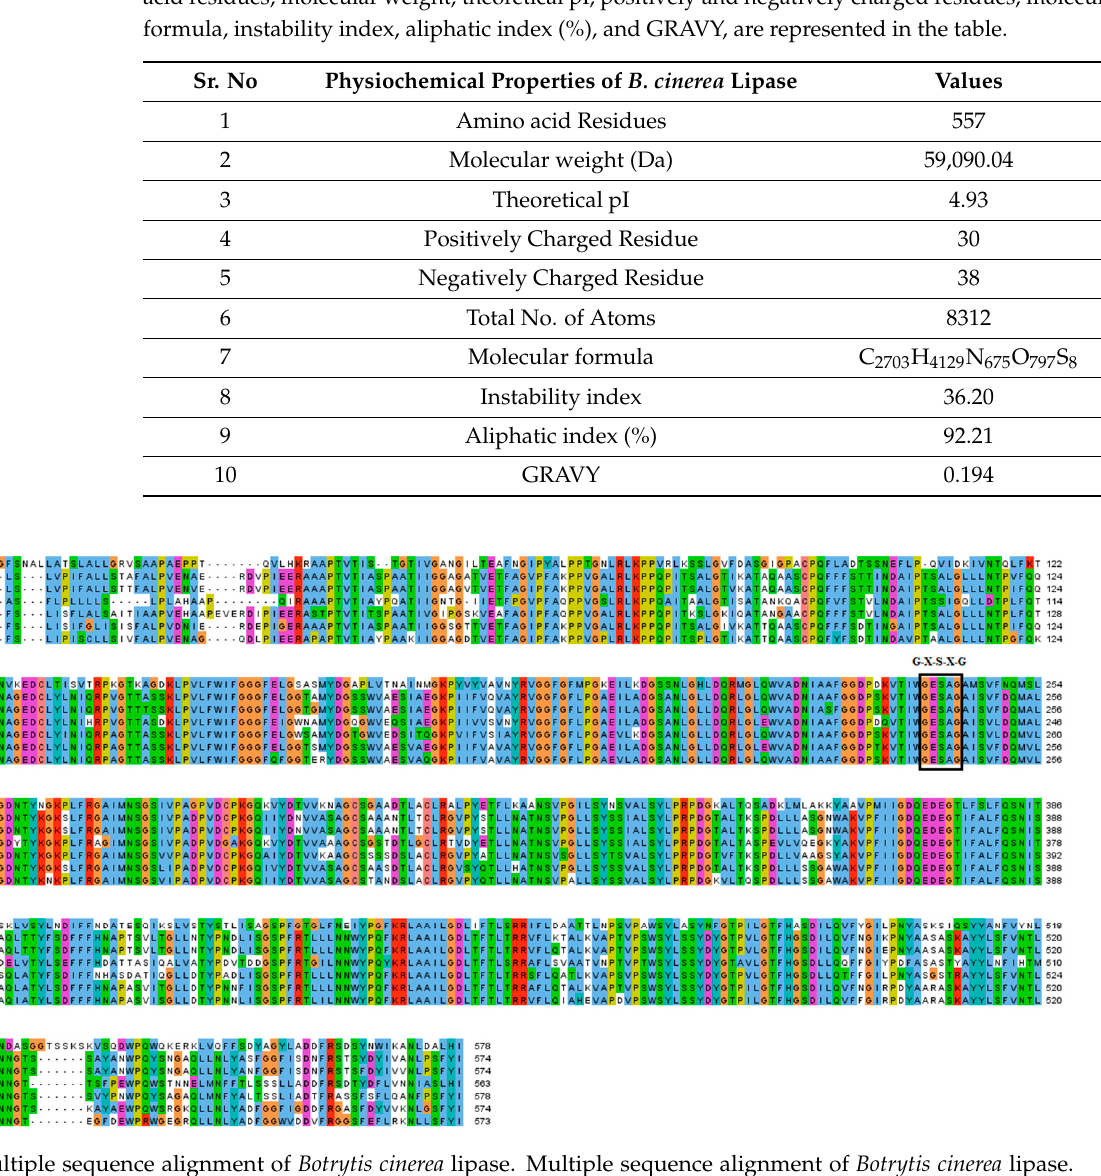
Figure 1. Multiple sequence alignment of Botrytis cinerea lipase. Multiple sequence alignment of Botrytis cinerea lipase. Conserved amino acids have been highlighted in colors. Catalytic triad (GXSXG) is shown in the box.